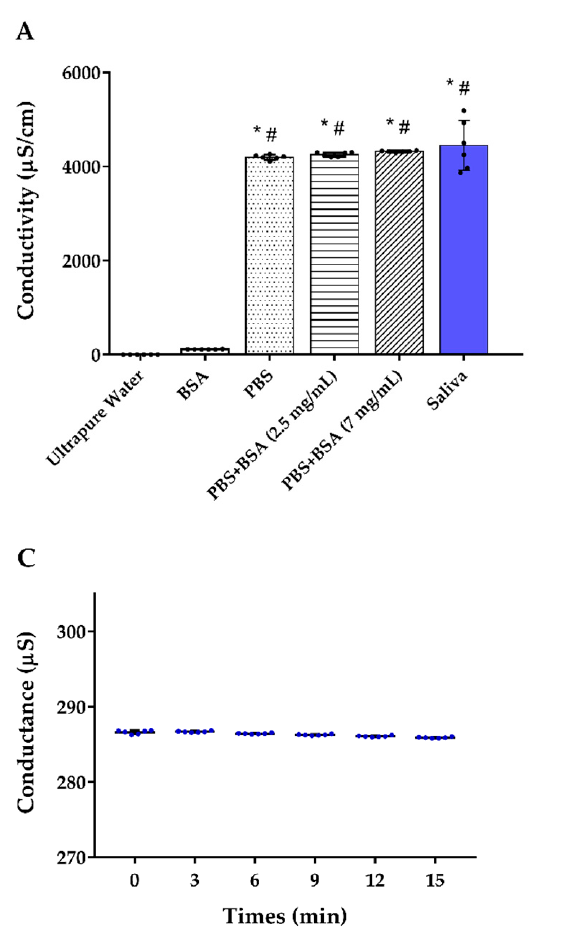
Figure 4. ( A ) Conductivity of the solution with different components. ( B ) Detection of the conductance of ultrapure water spiked in with BSA comparing our co-planar microelectrode and the commercial electrode. ( C ) Serial conductance measurements of the 6 individuals’ saliva at different time points. Abbreviations: BSA, bovine serum albumin; PBS, phosphate-buffered saline. * indicates p < 0.05 compared to ultrapure water; # indicates p < 0.05 compared to the BSA. Table 1. Characteristics of the study population and the correlation between salivary conductivity and continuous